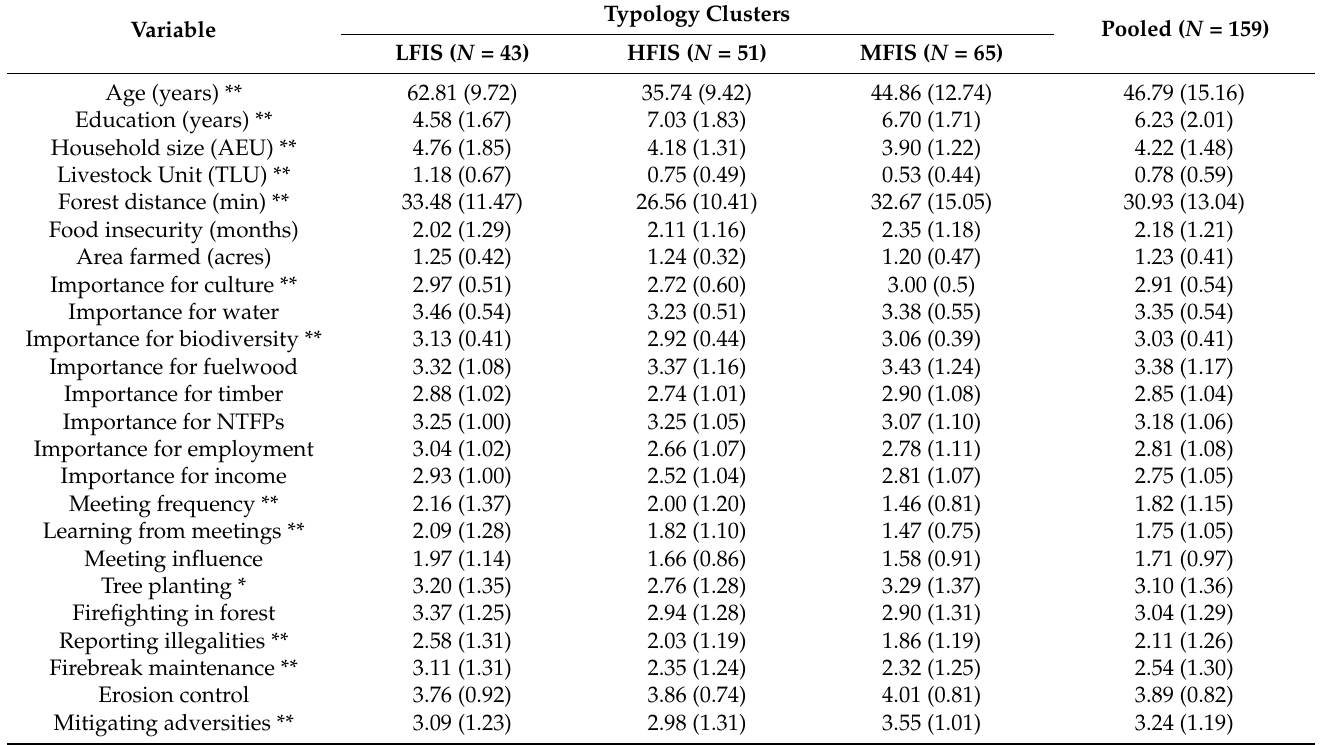
Table 4. Variation of socioeconomic characteristics management and utilization of the forest by